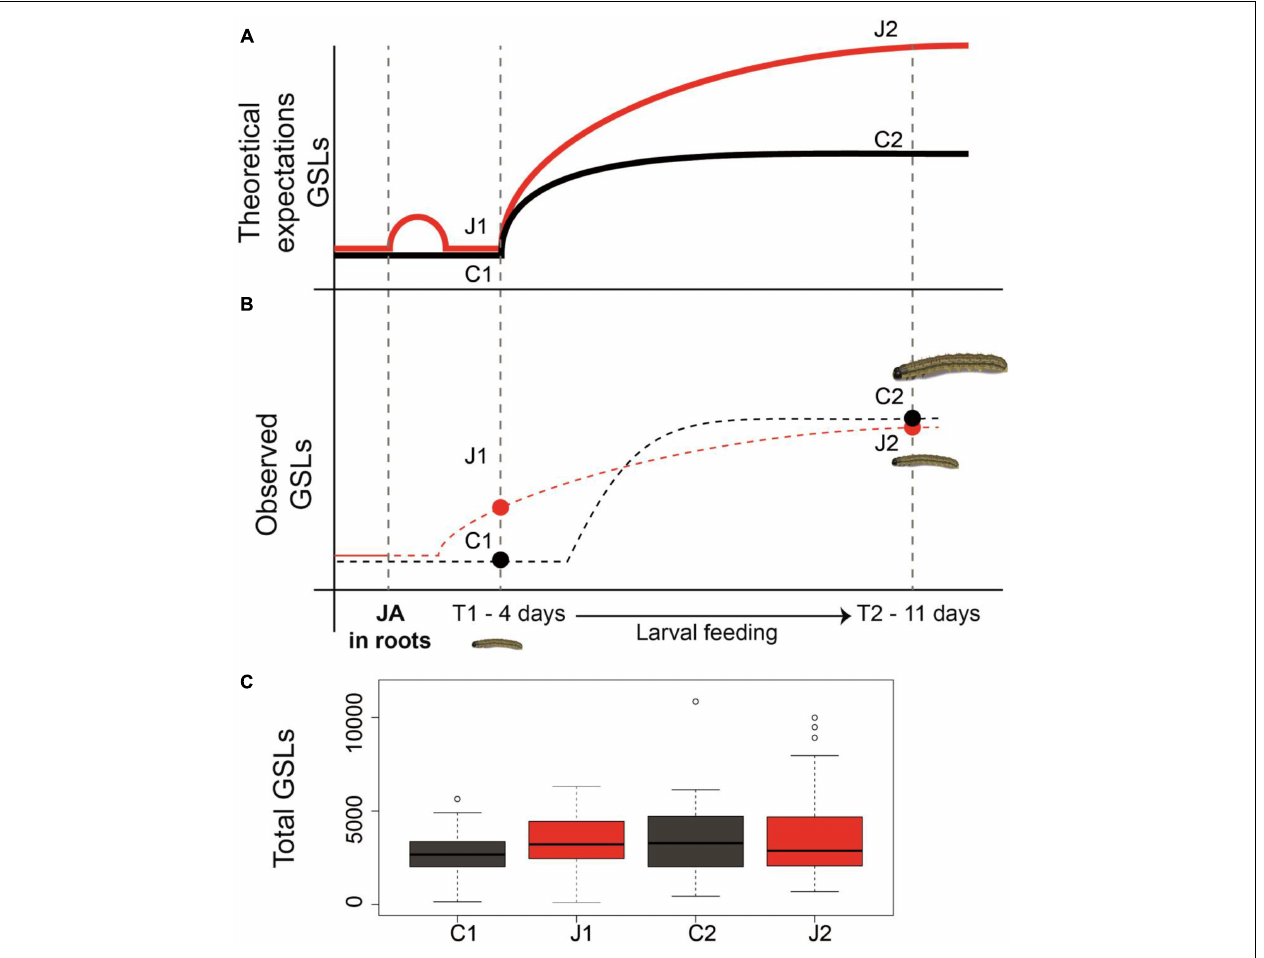
FIGURE 4 | Priming of defenses and resistance in plants. Panel (A) is showing the theoretical expectations of defense priming in plants based on the literature. Panel (B) shows the conceptual model of priming that was observed in this paper as well as the resistance bioassay with Spodoptera littoralis caterpillars. Dots represent the observed values of total GSL sampled at two time points. The dotted lines represent hypothetical GSL induction dynamics. Panel (C) shows how total glucosinolates levels (ng mg - 1 FW) vary across time and based on the two treatments of JA induction in the roots (J1 and J2), and no JA induction (C1 and